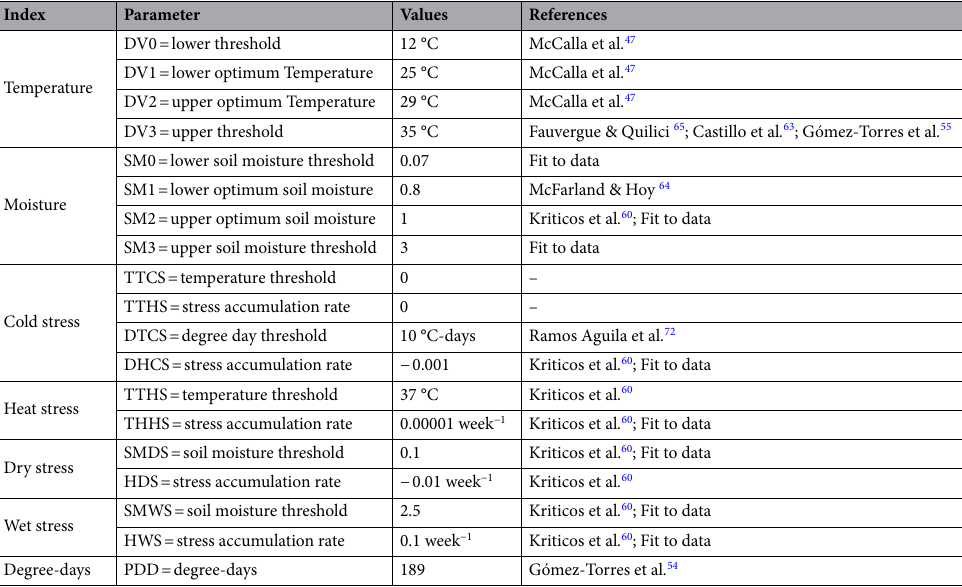
Table 1. CLIMEX parameter values used for Tamarixia radiata